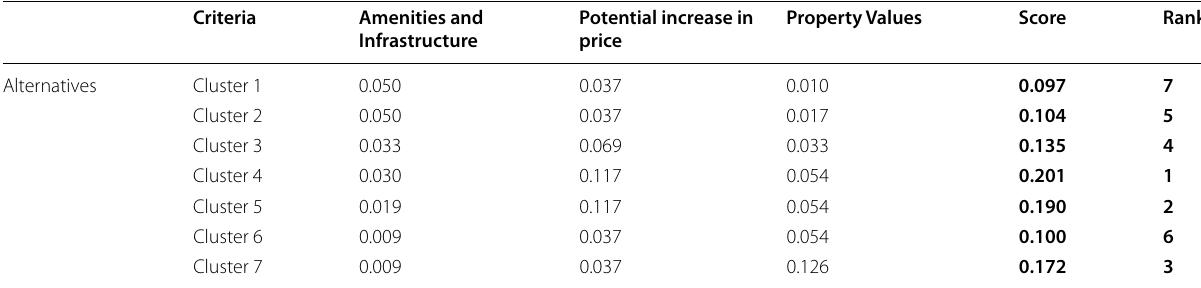
Table 6 Weighted Decision Matrix (without taking into consideration the effects of BRT)